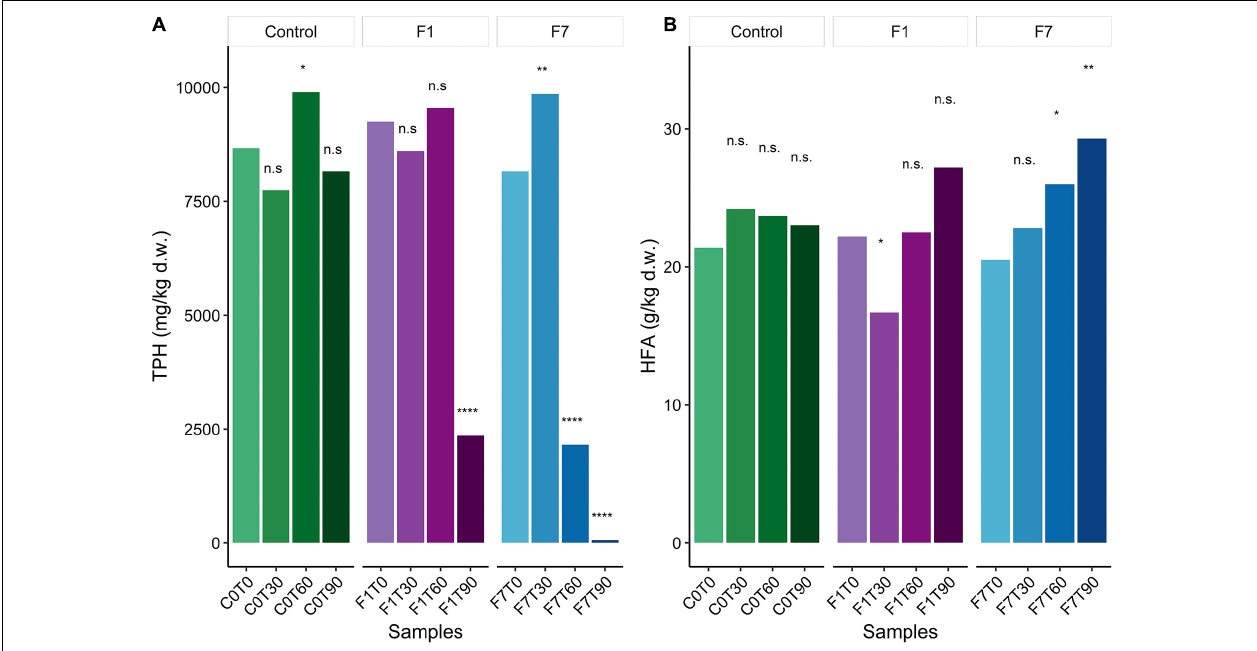
FIGURE 1 | (A) Average of Total Petroleum Hydrocarbon (TPH) content for datapoint triplicates, expressed as mg/kg per dry weight (ppm); (B) Average of humic and fulvic acids (HFA) content for datapoint triplicates, expressed as g/kg per dry weight ( ). Statistical significance was assessed by two-way RM ANOVA test (Days = matching factor) followed by Dunnett post-hoc test corrected for multiple comparisons. Group labels represent statistical significance against 0 Days (cid:104) datapoint within each Treatment (C0, control mesocosms, F1, F7) at α = 0.05 : n.s., not significative, *corrected p -value < 0.05, **corrected p -value < 0.01, ****corrected p -value <